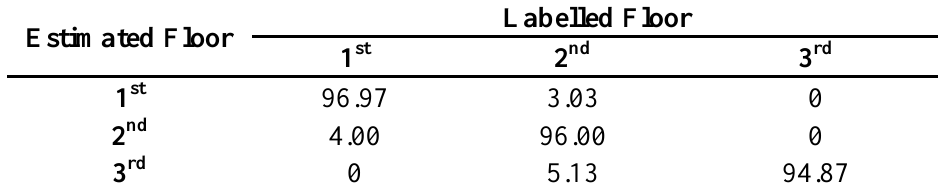
Table 8. Confusion matrix for floor detection using motion-assisted HMM wireless positioning (Unit: